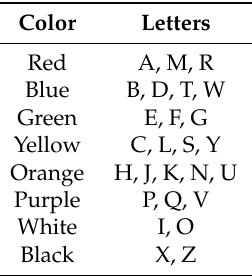
Figure 1. Synesthetic letter colorization by the evolving generative network: ( a ) generator input; and ( b ) generator output. Early training: 1st epoch; <3000 iterations. One letter per column. Iteration count progresses from top to bottom. Table 1. Grapheme-color associations of 6588 synesthetes. The most common color assignment reported for each letter is shown. After